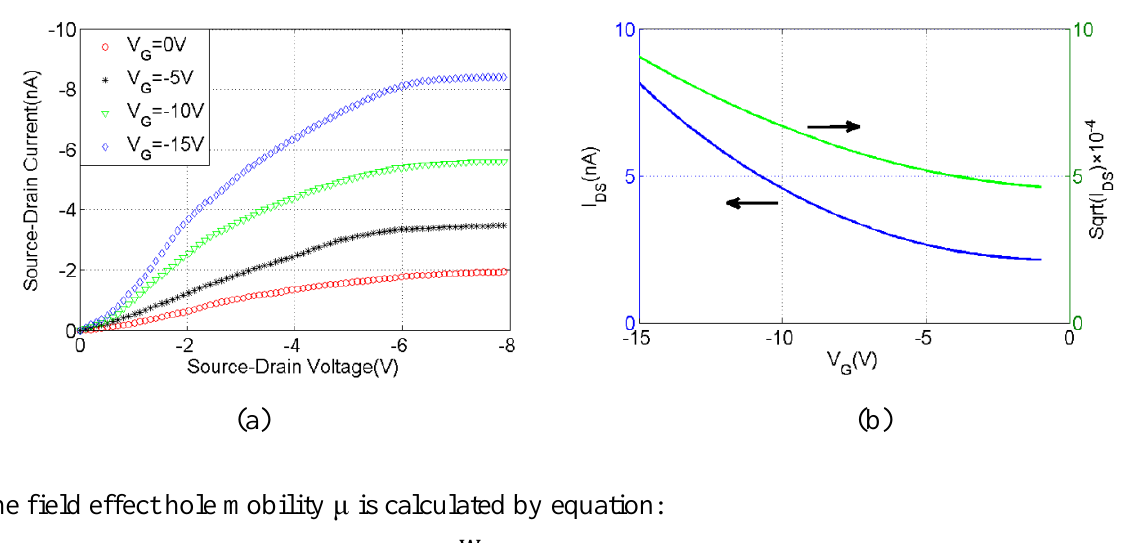
Figure 3. ( a ) Output characteristics of single Pani fiber. I gate voltage (V ). ( b ) Transfer characteristics of single Pani fiber. I G